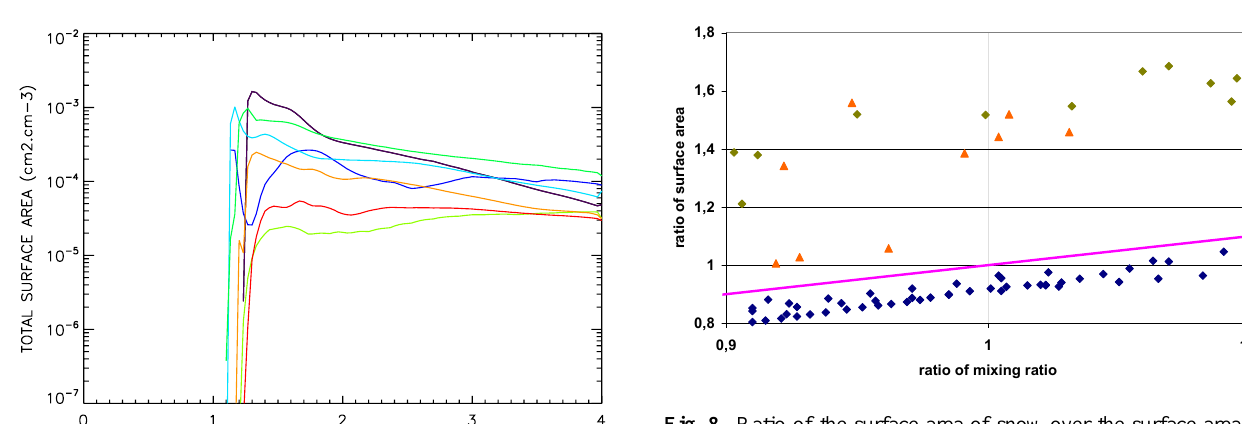
Fig. 8. Ratio of the surface area of snow over the surface area of pristine ice as a function of the ratio of the mixing ratio of snow over the mixing ratio of pristine ice (blue diamonds); the same for aggregates and pristine ice (orange triangles) and for aggregates and snow (green diamonds). The pink line is the location of the points for which a ratio of the mixing ratio would lead to the same ratio of the surface